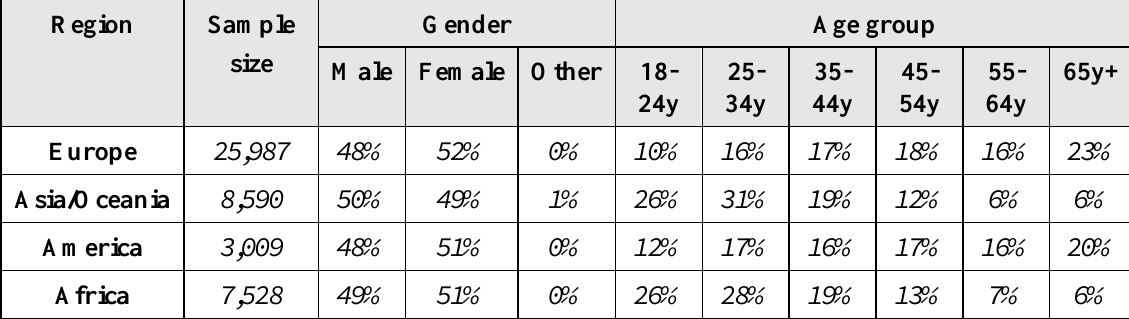
Table 2. Sample size, gender, and age group distribution by